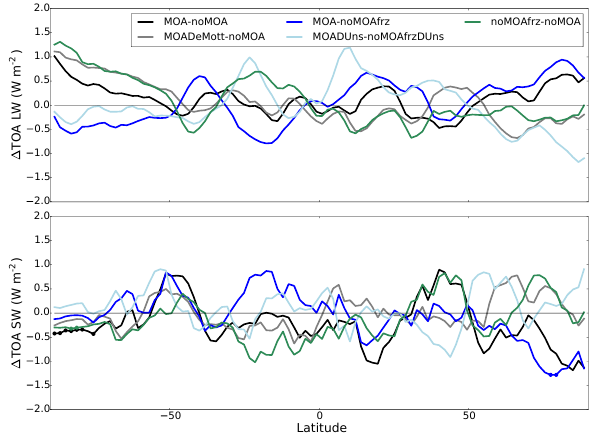
Figure 11. Zonal and multi-annual mean change in the top-of- atmosphere (TOA) solar (SW) and terrestrial (LW) radiative balance for the various free-running 10-year simulations. The black and gray curves indicate changes due to both the emission and ice nu- cleation of MOA, the blue-coloured curves correspond to changes stemming from MOA ice nucleation, and the green curve indicates changes due to the emission of MOA. It should be noted that the outgoing terrestrial radiation is defined to be negative, so a positive change is indicative of less outgoing radiation. Statistically signifi- cant changes at the 99% level are marked with dots on the respec- tive